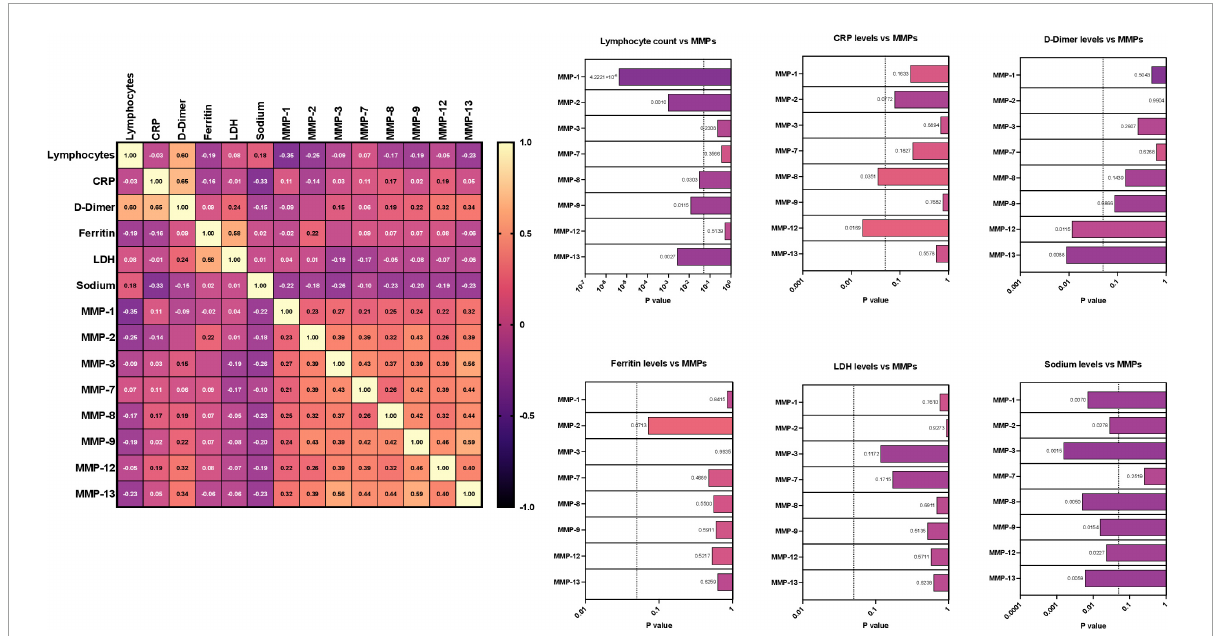
FIGURE4 Correlation between matrix metalloproteinases (MMP) levels and other laboratory parameters. Multiparametric matrix correlation plot of MMPs-1, 2, 3, 7, 8, 9, 12 and 13 and laboratory parameters (Lymphocyte, CRP, D-Dimer, Ferritin, LDH, Sodium) with MIS-C and COVID-19. Spearman’s correlation coefficients are visualized by color intensity. P values and spearman r values are ordered by hierarchical clustering in the study